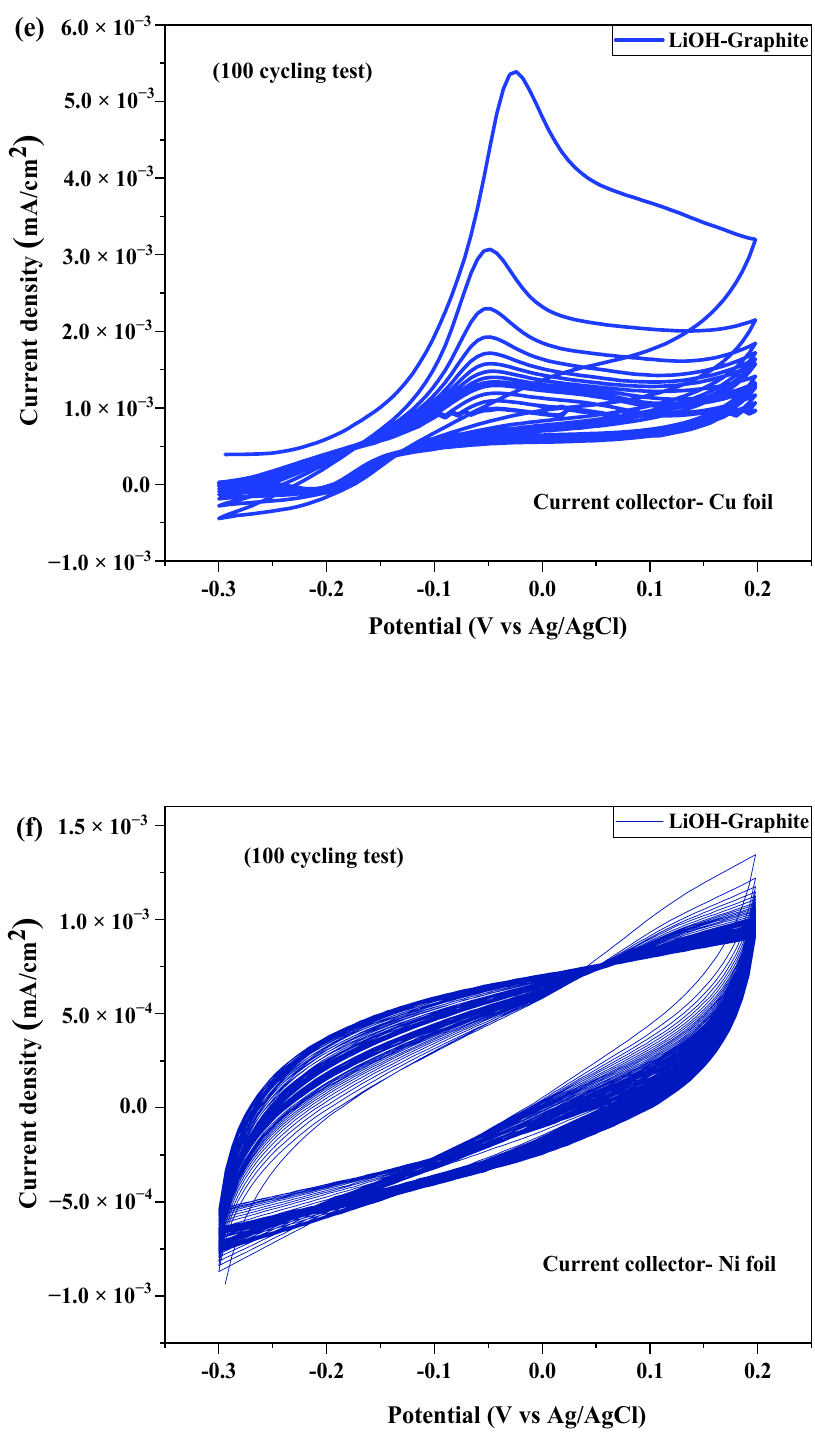
Figure 10. Cyclic voltammetry (CV) test (current collector—Cu foil and Ni foil and 5% KOH elec- trolyte) under 100 cycles. ( a ) LiOH-YP80F with Cu-foil; ( b ) LiOH-YP80F with Ni-foil; ( c ) LiOH-YP50F with Cu-foil; ( d ) LiOH-YP80F with Ni-foil; ( e ) LiOH-Graphite with Cu-foil; ( f ) LiOH-Graphite with Ni-foil.